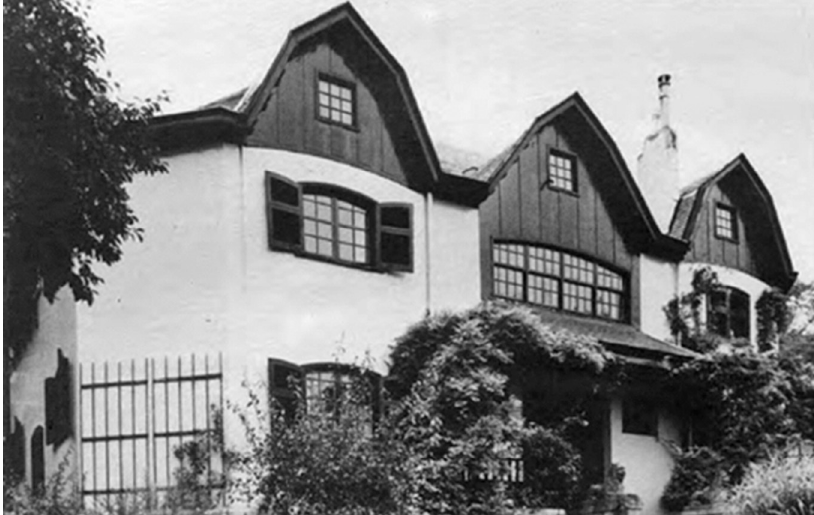
Figure 11. Henry van de Velde, the ‘Bloemenwerf’ house, in Uccle-Bruxelles, 1895. The forms are indicative of the direct influence English Country houses had on the artist. (Bekaert, Geert. “L’influence de Viollet-Le-Duc Sur L’architecture En Belgique et Aux Pays-Bas Vers 1900.” Translated by Willy